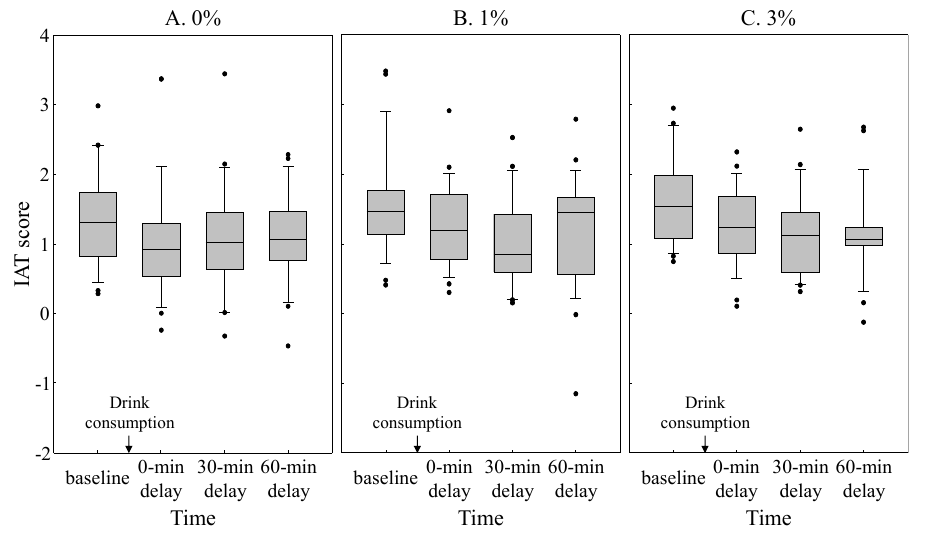
Figure 3. Boxplots for each of the alcohol concentrations (A: 0%, B: 1%, and C: 3%) show the median, first quartile, and third quartile of IAT scores as a function of time (baseline, 0, 30, and 60 min delay). Whiskers indicate scores to the 10th (downward) and 90th (upward) percentiles. The dot plots show outliers above (or below) the 90th (or 10th) percentile.